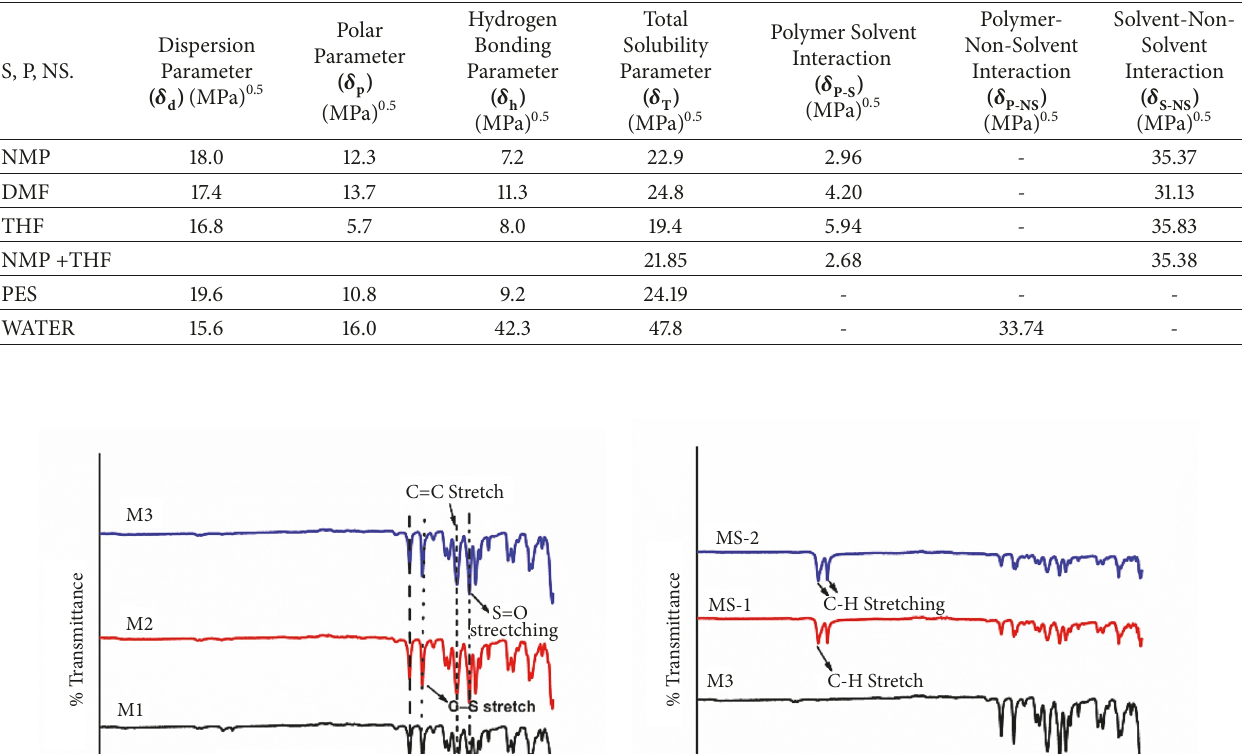
Table 2: Hansen solubility parameter values of polymer, solvent, nonsolvent, and their interaction [34].